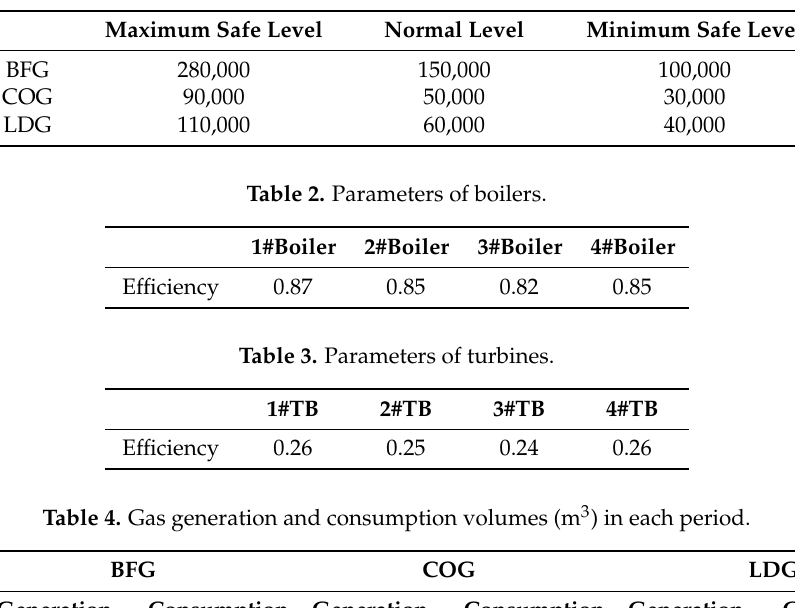
Table 1. Maximum safe level, normal level, and minimum safe level (m 3 ) of gasholders.